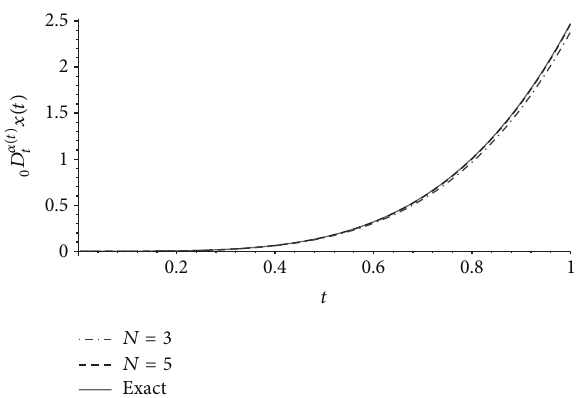
Figure 1: Exact (45) and numerical approximations of the left Riemann-Liouville integral 0 𝐼 𝛼(𝑡) 𝑡 𝑥(𝑡) with 𝑥(𝑡) = 𝑡 4 and 𝛼(𝑡) = (𝑡 + 1)/4 obtained from Theorem 6 with 𝑛 = 2 and 𝑁 ∈ {3, 5} . The error (48) is 𝐸 ≈ 0.02169 for 𝑁 = 3 and 𝐸 ≈ 0.00292 for 𝑁 = 5 .